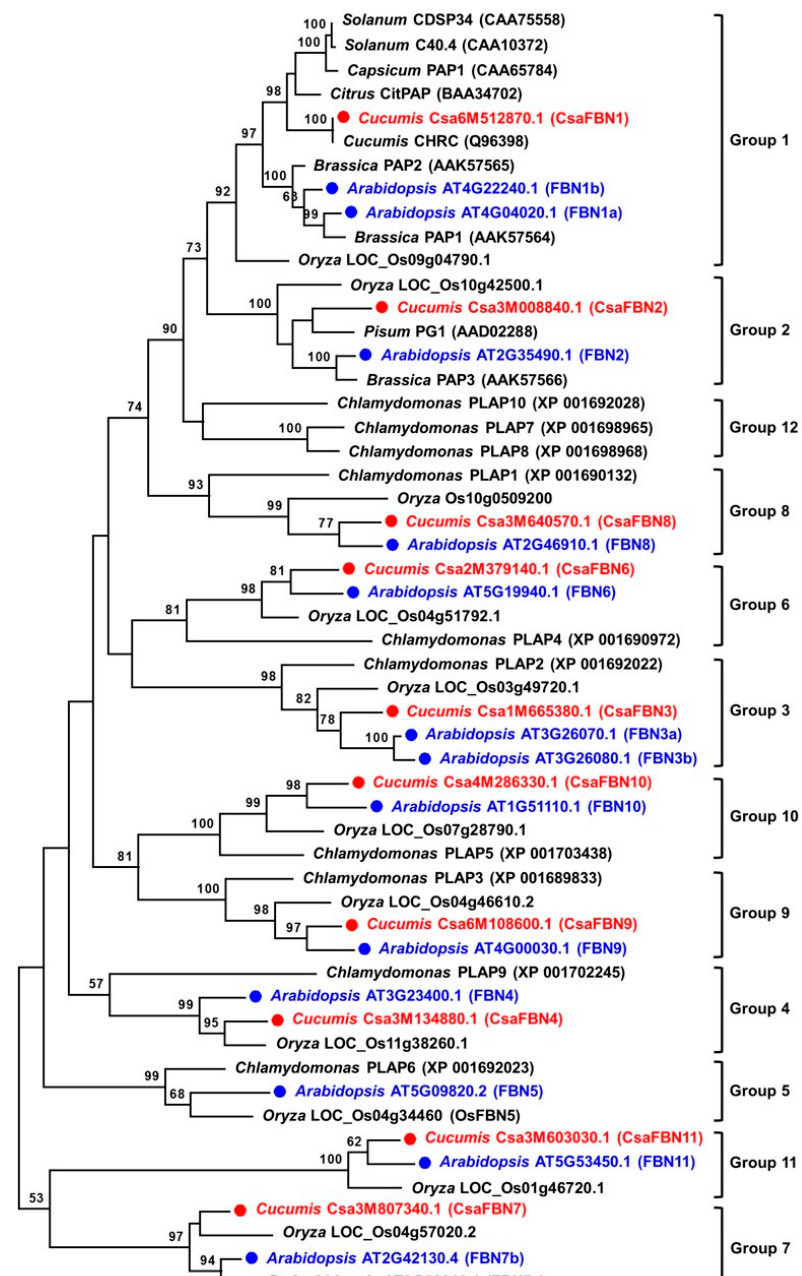
Figure 1. Phylogenetic relationship of FBN proteins in cucumber and other plant species. Phylogenetic tree was generated by the Maximum Likelihood (ML) method using MEGA 7.0, after alignment of deduced amino acid sequences by ClustalW. Numbers in the nodes are the bootstrap support values from 1000 replicates. Scale bar represents the number of amino acid substitution per site. FBN genes reported in A. thaliana and identified in Cucumber (this study) are shown in blue and red, respectively. Two alternative spliced forms, Csa3M640570.2 and Csa3M807340.2 , were not included in this tree. FBN genes in other plant species ( Brassica , Capsicum , Chlamydomonas , Oryza , Pisum and Solanum genus ) and FBN classification (Group 1 to 12) were based on Singh and McNellis [15] and Kim et al. [23].